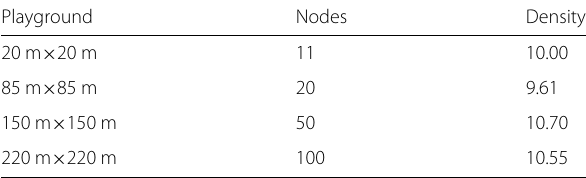
Table 12 Topologies with constant network